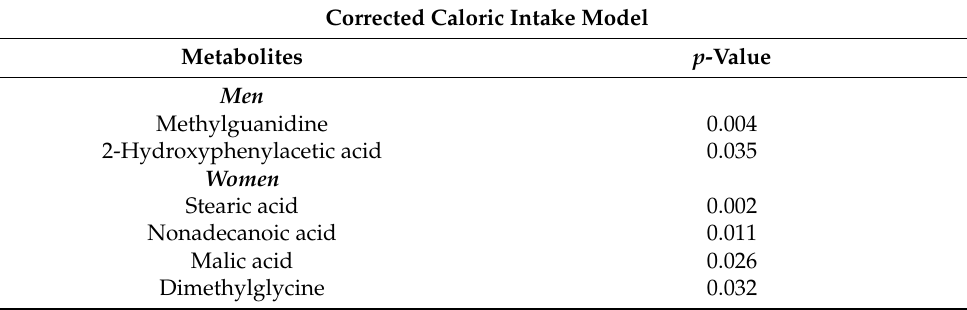
Table 5. Corrected MANOVA assessing caloric intake and the